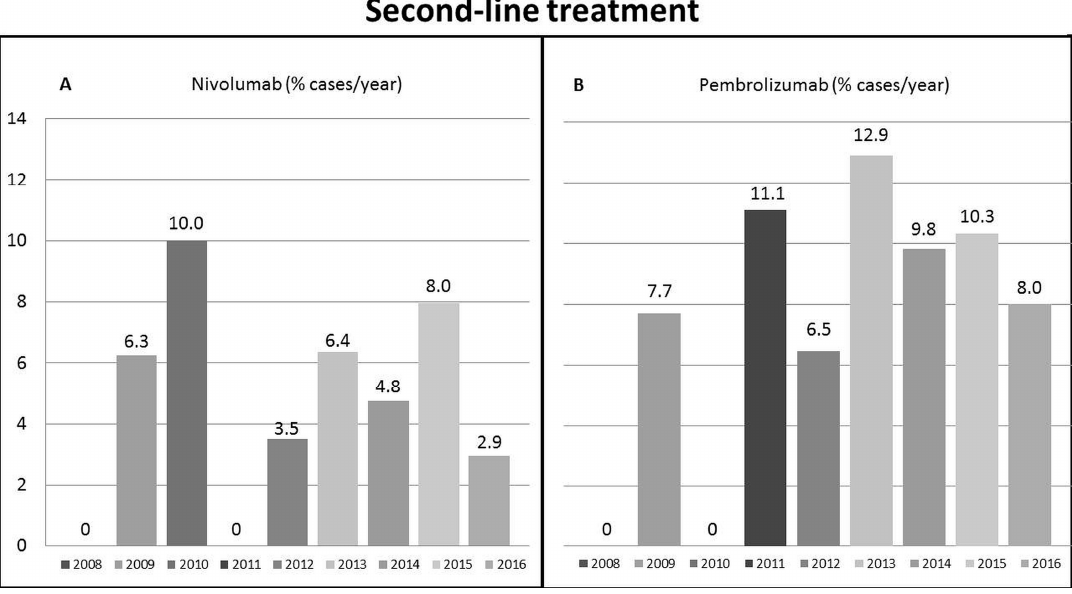
Figure 3. Proportion of patients within the Italian Liver Cancer cohort meeting the criteria for: first-line pembrolizumab treatment ( A ); or second-line pembrolizumab treatment ( B ).